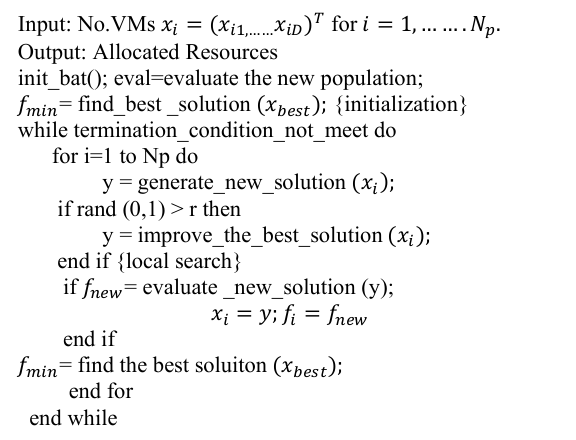
Algorithm 3. Pseudocode of improved bat algorithm